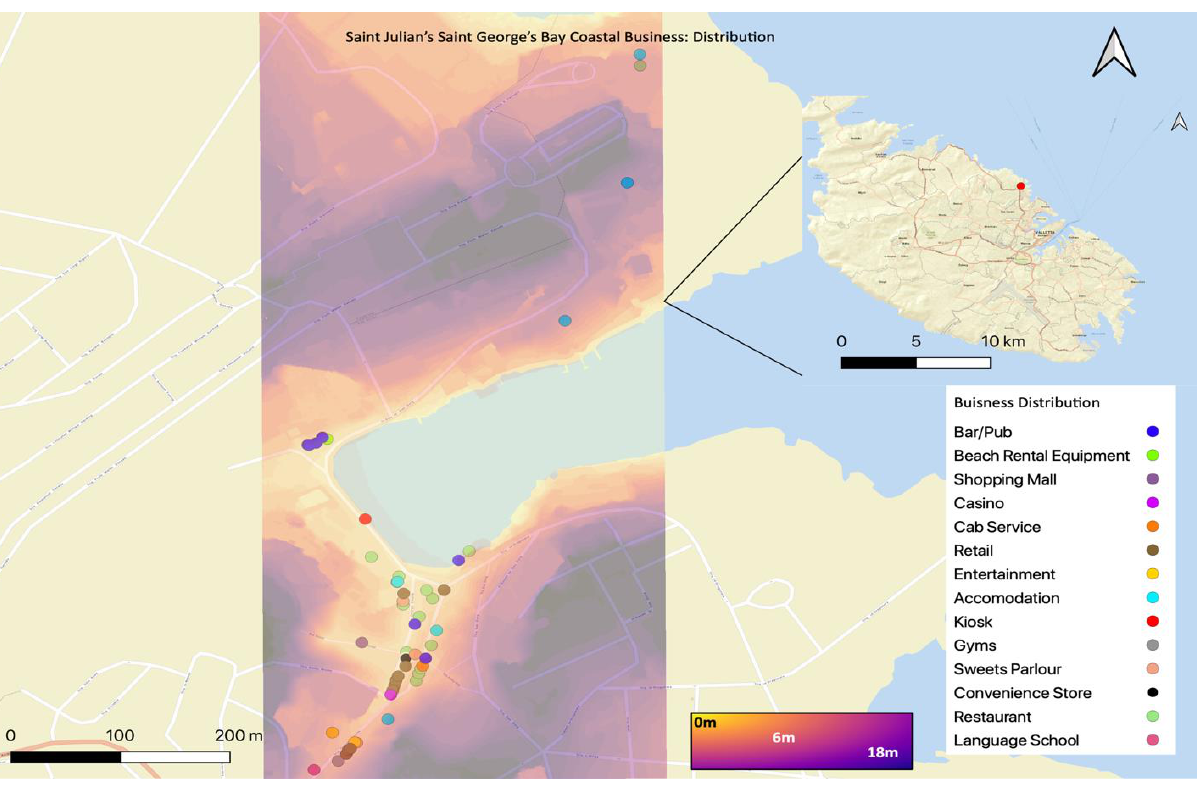
Figure 9 . Coastal businesses’ distribution in St Julian’s: Balluta to Spinola Bay (Part 1 of St Julian’s).